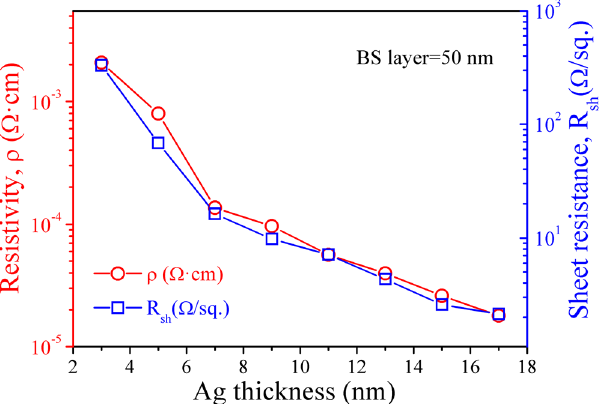
Figure 2. The dependence of resistivity and sheet resistance for BS/Ag/BS multilayer flexible thin films on the Ag mid–layer thickness. Inset is the schematic diagram of parallel resistors in multilayer flexible thin